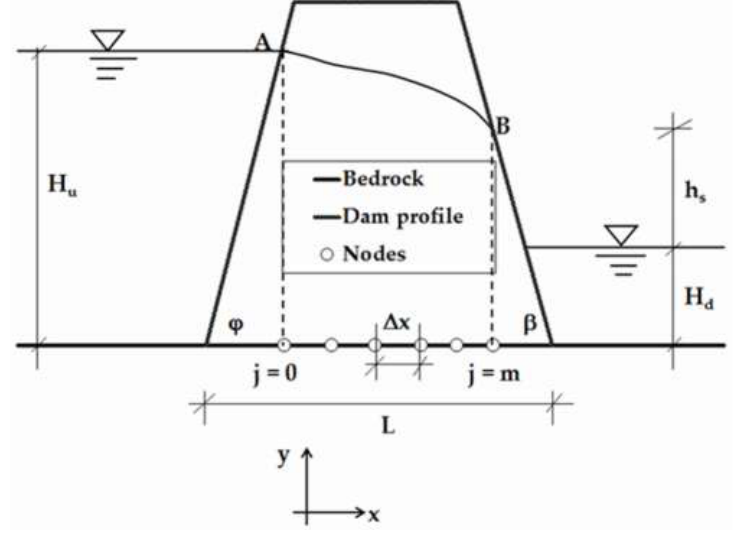
Figure 4. Definition sketch for seepage flow through a trapezoidal profile dam.